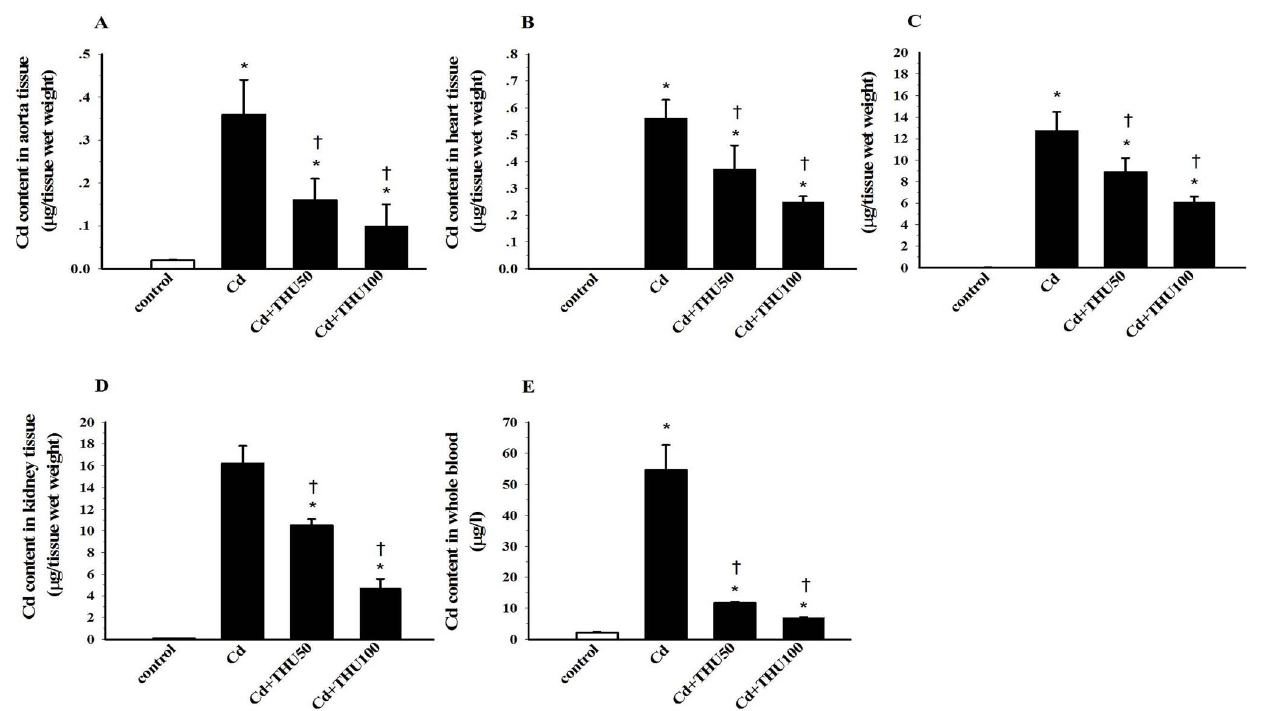
Fig. 6. Effect of THU on Cd accumulation in the blood and tissues of mice exposed to Cd. Results are expressed as mean ¡ SEM., n 5 6-8/group. * P , 0.05 compared with normal control group, { P , 0.05 compared with Cd control